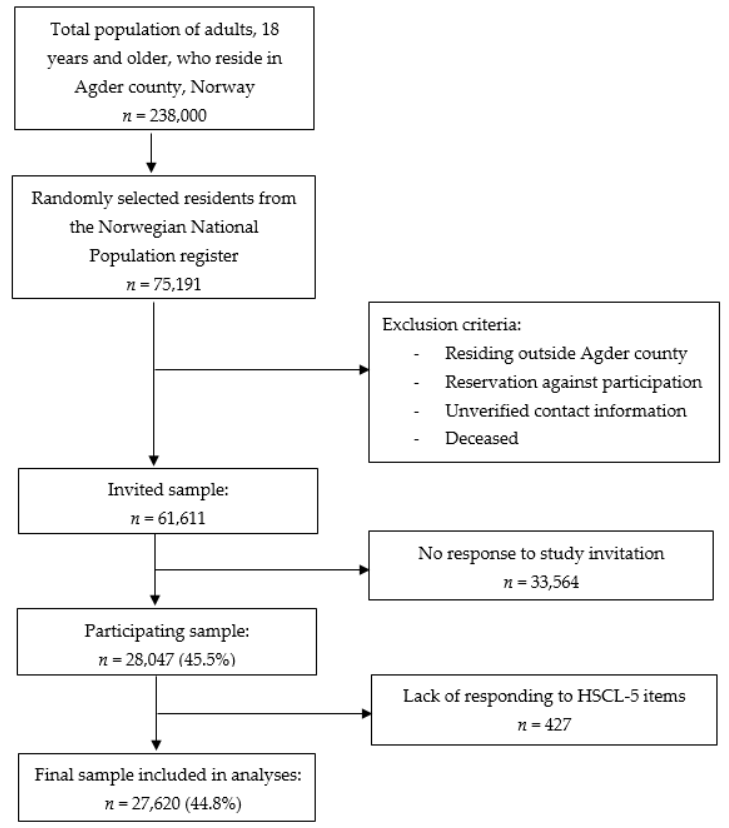
Figure 1. Sample collection flow chart.